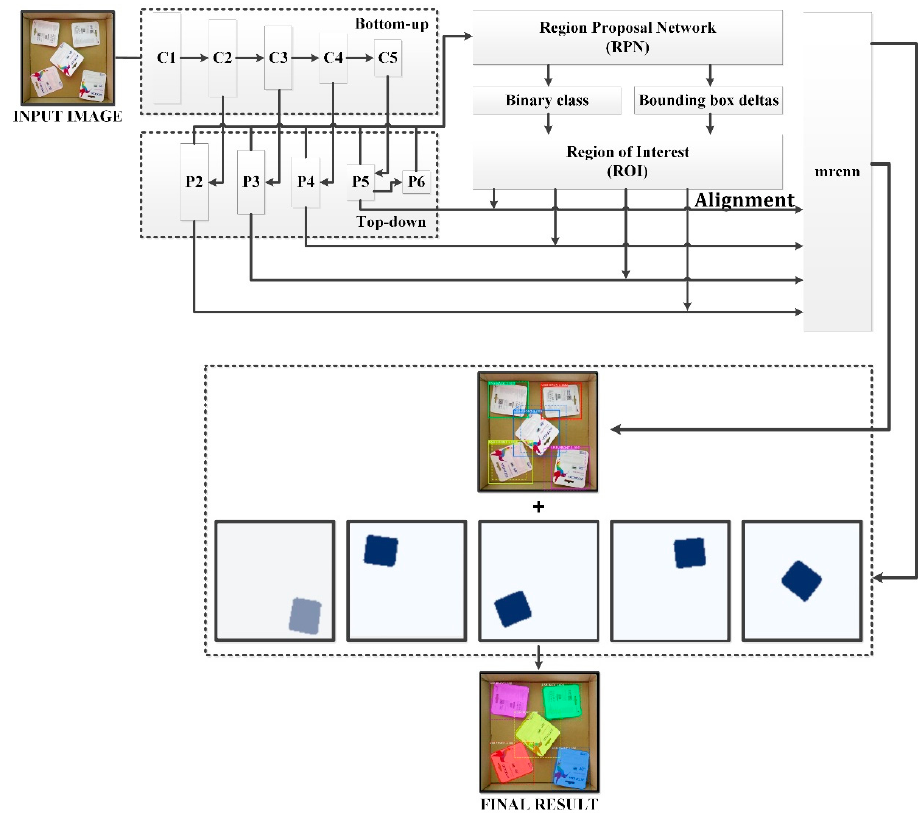
Figure 6. Implementation of deep learning for image processing.